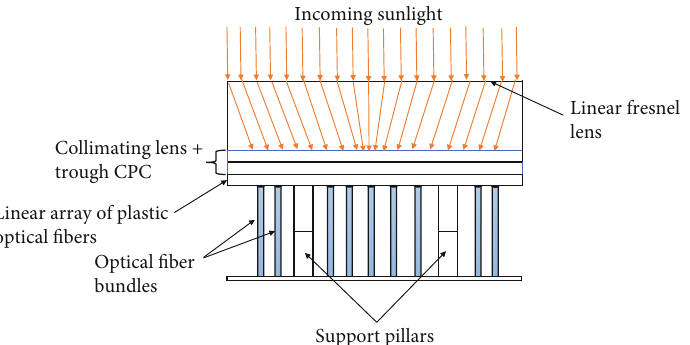
Figure 2: Front view of the physical layout of linear Fresnel lens daylighting system by introducing the trough compound parabolic concentrator (CPC) before the optical fi bers (source: adapted from [45]).